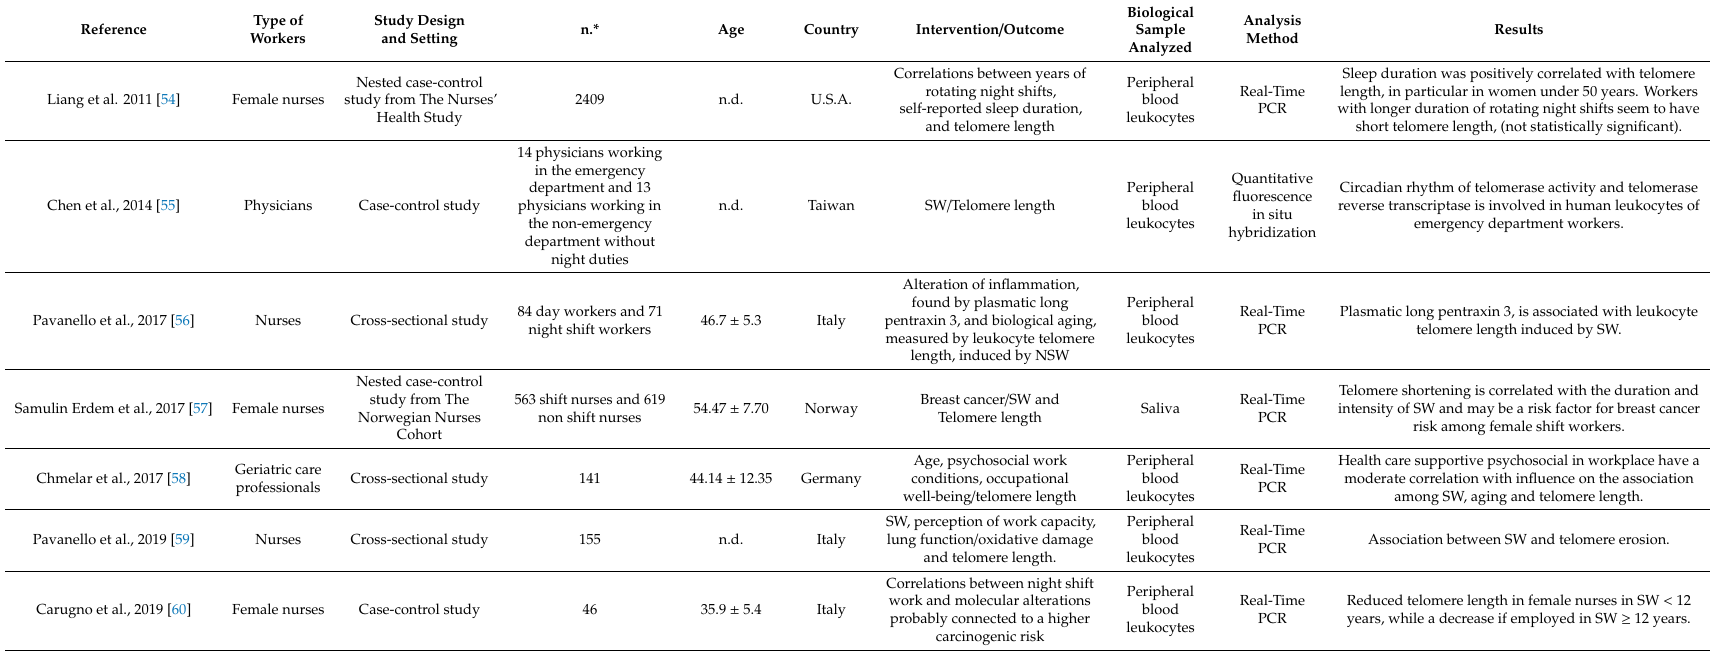
Table 1. Characteristics of suitable